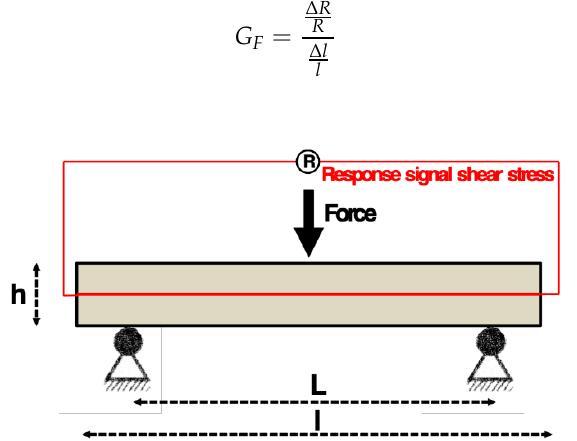
Figure 3. Test device, specimen and sensor layout (sensor fibre embedded in the neutral plane) for the three-point bending test on a rectangular unidirectional GF/PP composite with the fibres in the direction of the specimen’s length axis.